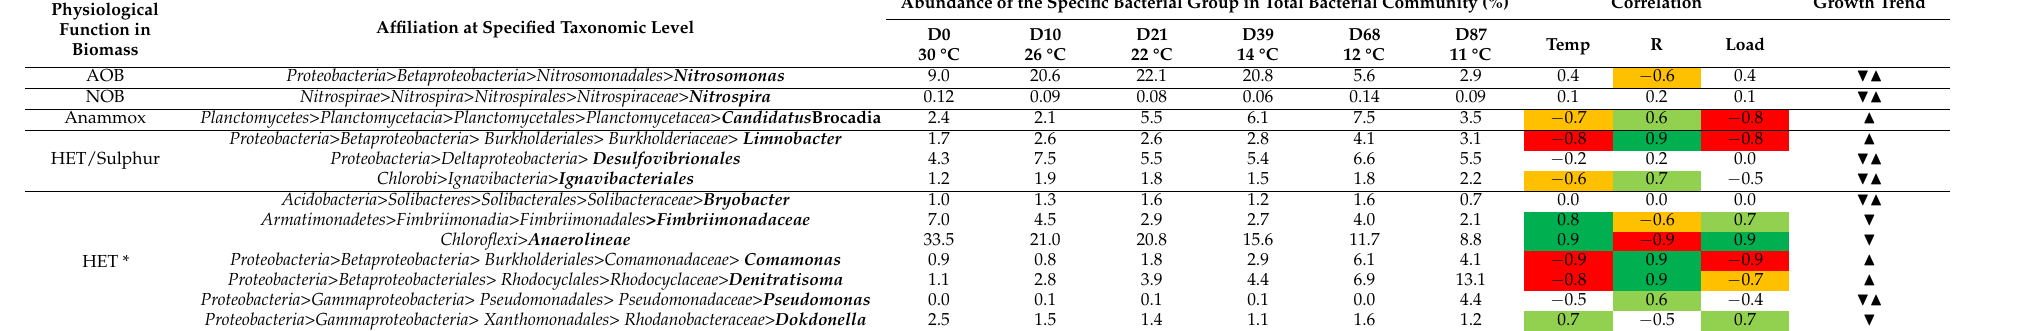
Table 3. Percentage of the specified bacterial taxa in the total microbial community with the correlation matrix reflecting dependencies between individual taxa abundance against temperature, NH 4 -N load and R ratio. The colors indicate correlation direction and strength (red and orange—strong and moderate negative; dark and light green—strong and moderate positive,